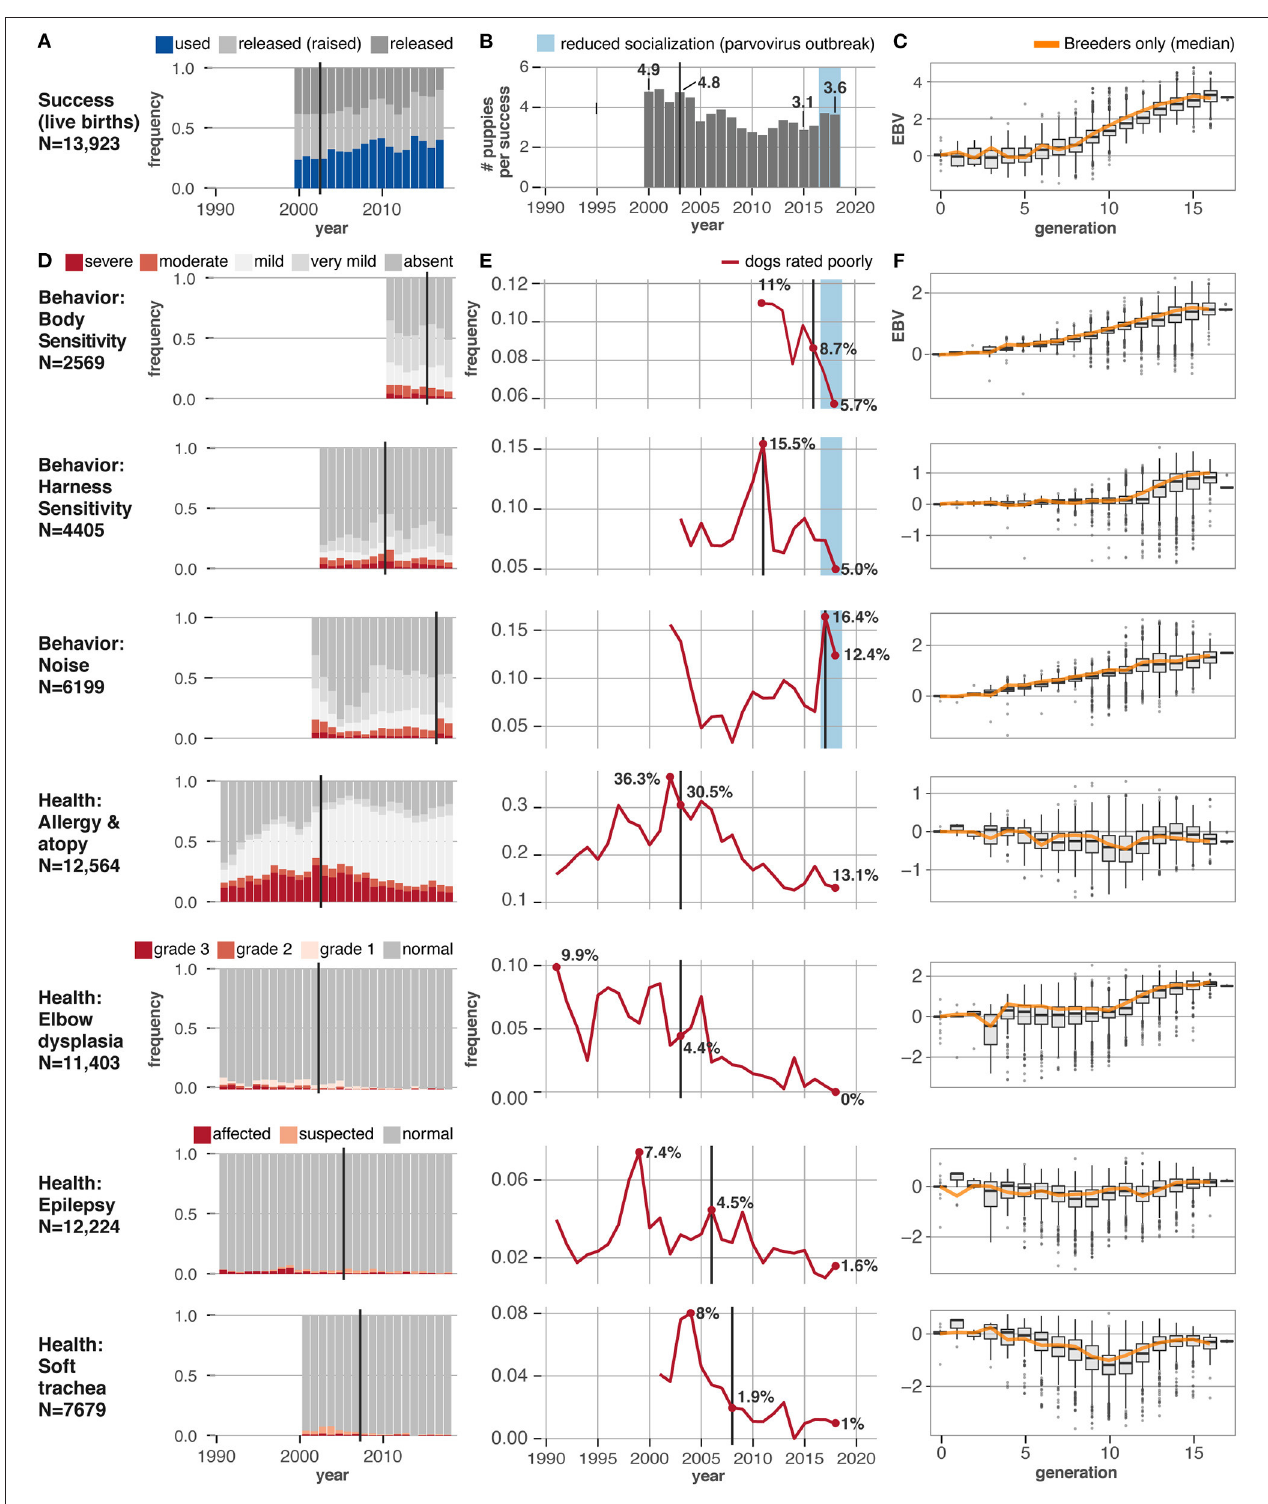
FIGURE 4 | Behavioral and health traits change in response to EBV selection. Eight traits under selection in the Guiding Eyes for the Blind population show varying responses to the onset of selection using EBVs. Vertical black lines show when EBV selection for each trait was started. (A) Change in fraction of dogs successfully placed as guide dogs per year, starting in 2000, when the current assessment criteria were implemented. (B) With improving success rates, the number of puppies produced by Guiding Eyes for each successful dog has dropped over time. (C) The EBV scores for success, as a trait, have increased over the last 17